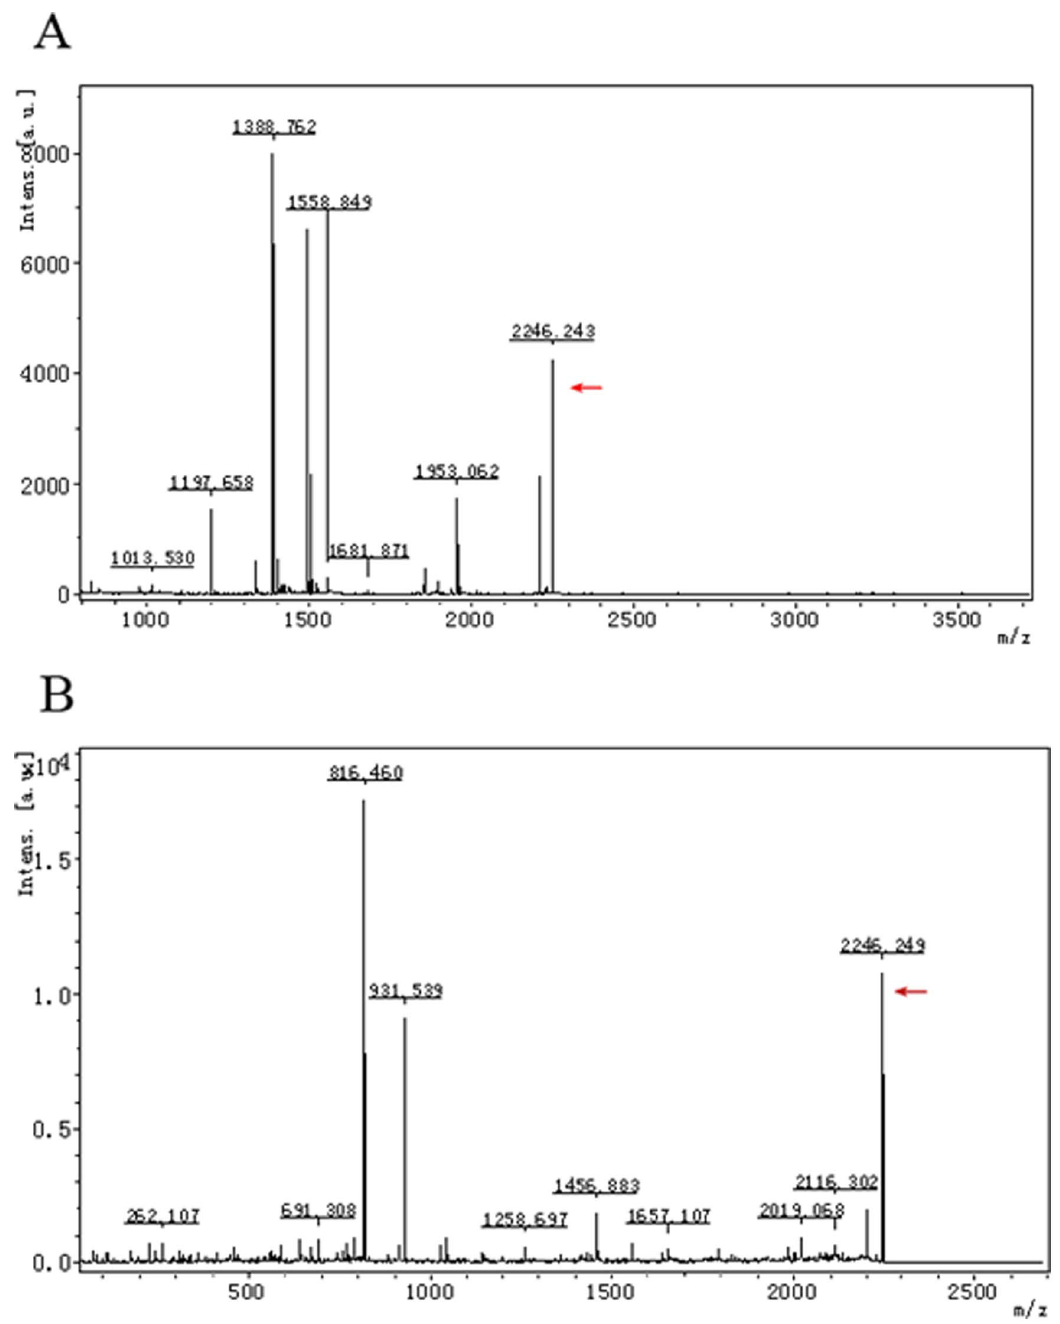
Figure 2. Representative PMF and MS/MS spectra. Spot 16 is identified as ArgK. (A) PMF spectrum; (B) MS/MS spectrum.